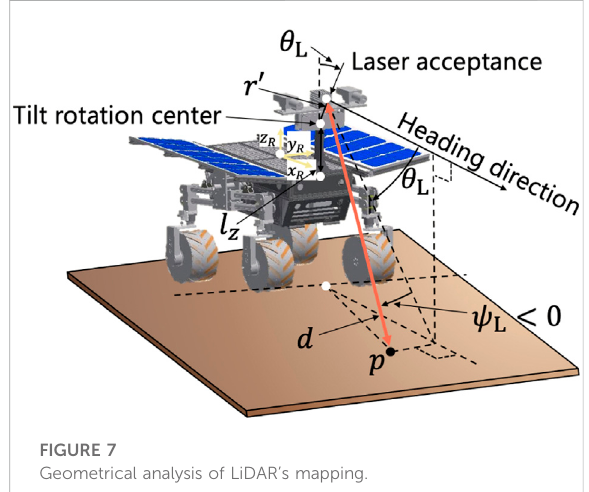
FIGURE 7 Geometrical analysis of LiDAR ’ s